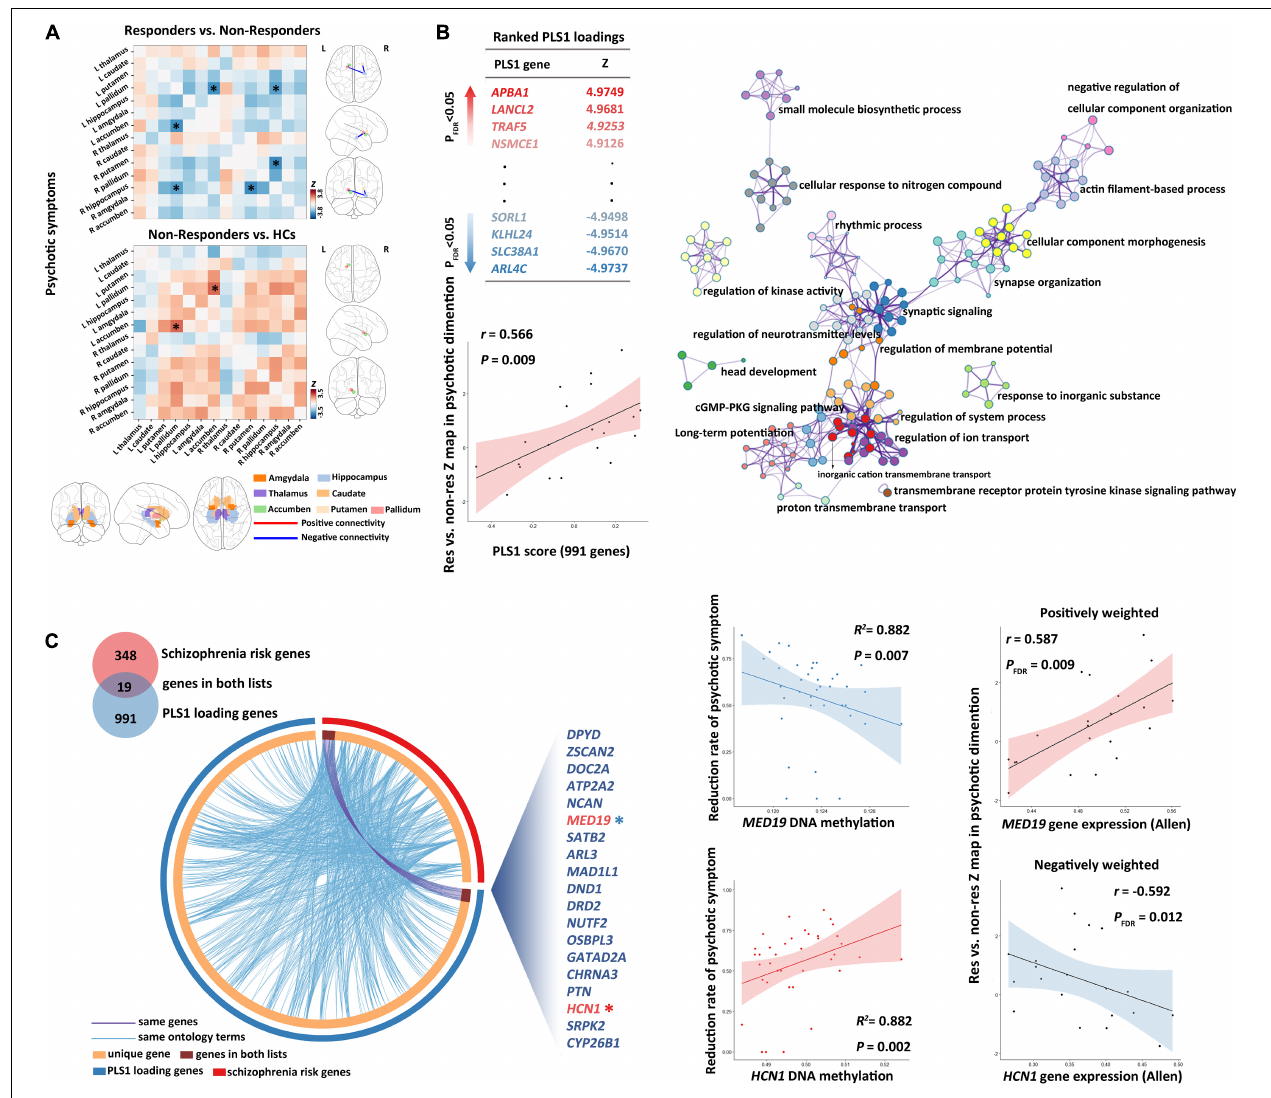
FIGURE 3 | Subcortical connectome, transcriptomic basis, and DNA methylation biomarkers for treatment response of psychotic symptoms. (A) Between-group comparisons showed that non-responders had a higher baseline structural covariance in the putamen–hippocampus–pallidum–accumbens pathway compared with responders. (B) Partial least squares (PLS) regression analysis demonstrated that expression values of 991 genes in the PLS1 were spatially associated with subcortical connectome variations related to psychotic symptom response. Metascape was then used to align the KEGG pathways and GO biological processes for the PLS1 genes. PLS1 genes were primarily enriched in the neuronal system, ion transport, and cellular process. Each circle node represents an enrichment term. Nodes with the same color belong to the same term (i.e., cluster). The circle node size is equal to the input genes number included in that cluster. (C) The DNAm of overlapping genes (shown in the Circos plot) between PLS1 genes and schizophrenia risk genes demonstrated robust correlations with treatment response of psychotic symptoms. GO, gene ontology; KEGG, Kyoto encyclopedia of genes and